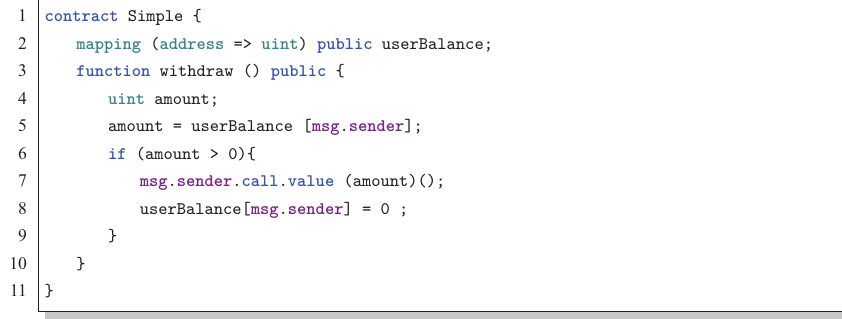
Figure 2. An example smart contract with reentrancy